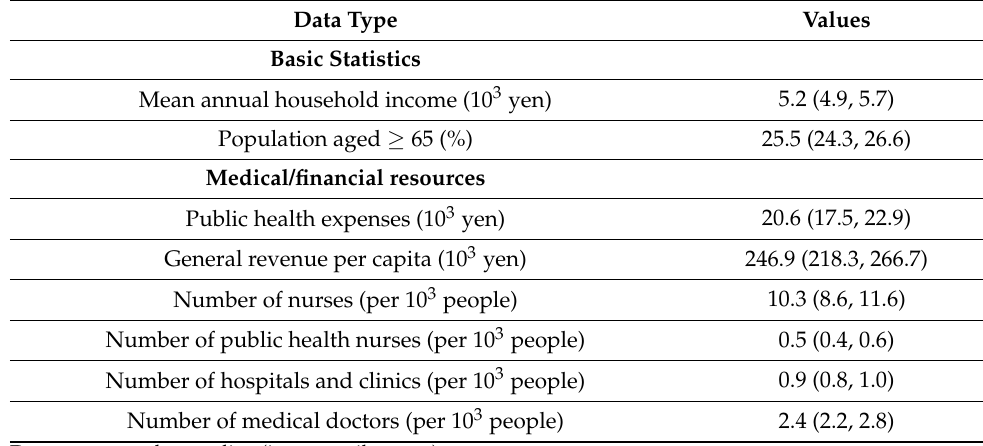
Table 2. Data on availability of resources across 47 prefectures used in the